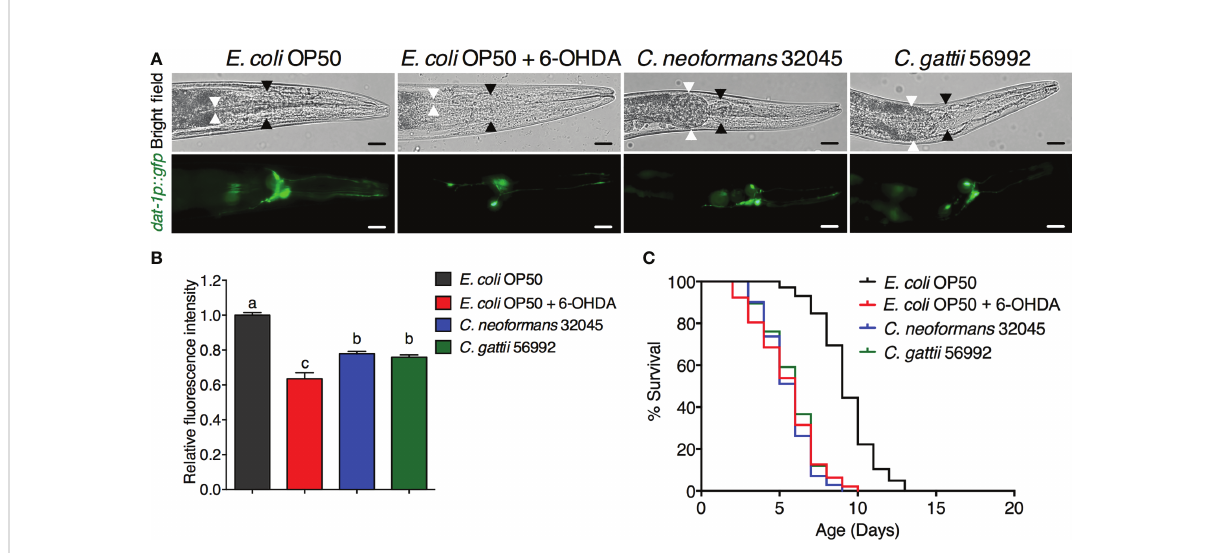
FIGURE 1 Infections of C neoformans and C gattii induced DA neuronal degradation are similar to 6-OHDA toxicity in C elegans . (A) The BZ555 worms that expressing GFP on DA neurons were exposed to either C neoformans (ATCC#32045), C gattii (ATCC#56992) or 6-OHDA. Upon infection, the cryptococcal yeast cells were seen at the distal area of the abnormally distended gastrointestinal tract of worms. Black arrowheads indicate the worm pharyngeal grinder. White arrowheads indicate the intestinal lumen of the nematode. Worms from all experiments were photographed alive. Scale bar = 20 m m. (B) Quantitation of GFP expression in DA neurons was measured by using ImageJ software. The data represented as mean ± SD (n = 30). a – c Indicated statistically signi fi cant differences between experimental conditions ( P < 0.05) by two-way ANOVA. (C) Percent survival of worms fed with E coli OP50/6-OHDA, C neoformans or C gattii. Worms that fed with E coli OP50 alone were served as mock-infected controls (n = 50). Survival was analyzed using Kaplan-Meier lifespan analysis. P -value was calculated using log-rank test. Mean lifespan differences between each condition was summarized in Table